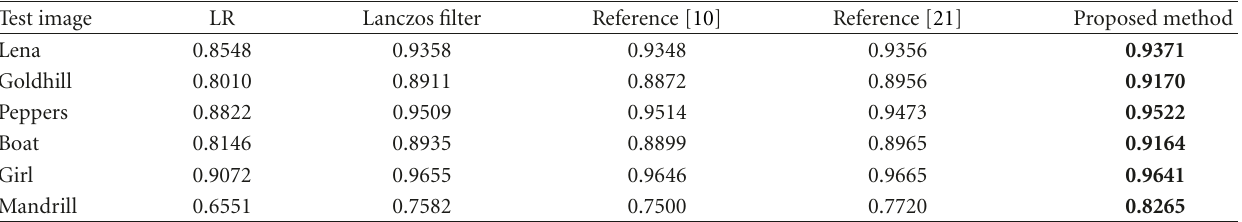
Table 2: Image enlargement performance comparison (SSIM) of the proposed method and the conventional methods (magnification factor =